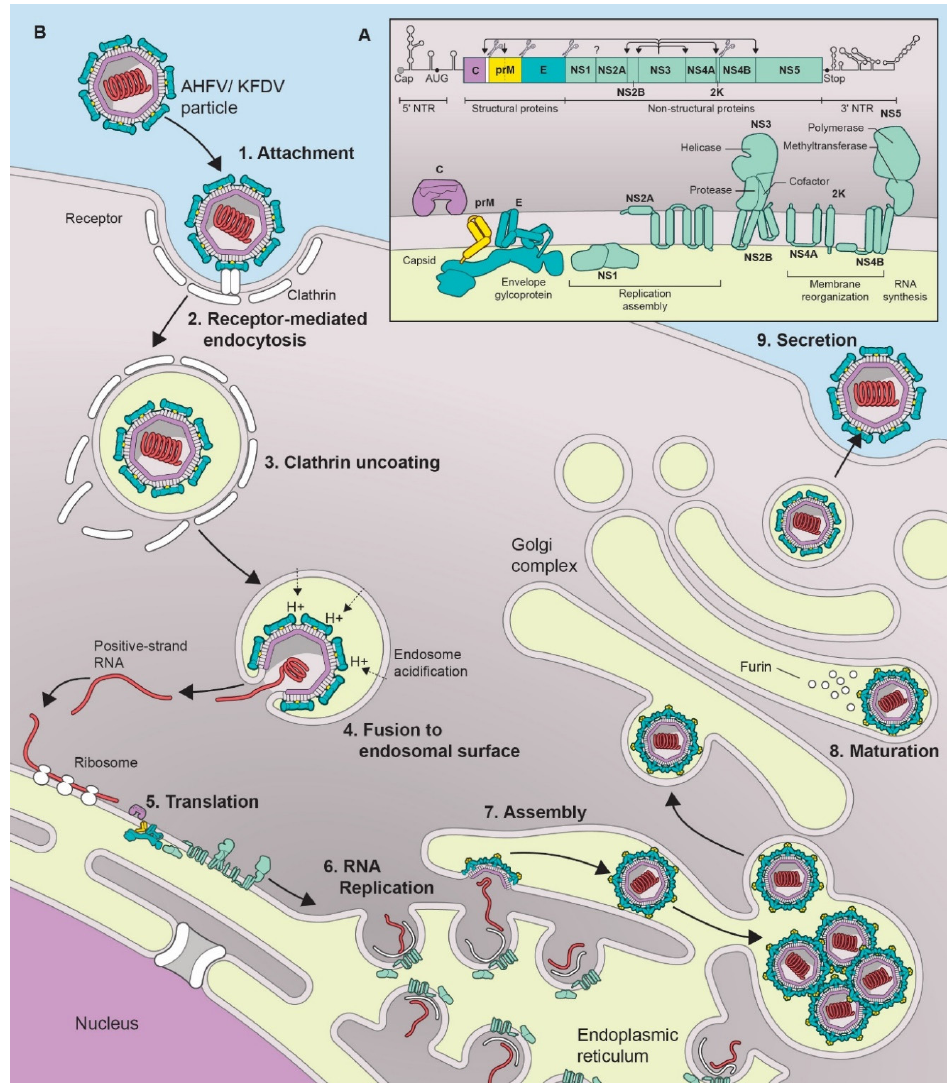
Figure 1. Flavivirus replication cycle and genome structure. ( A ) Schematic of a flavivirus genome, polyprotein , and the mature viral proteins. ( B ) Lifecycle of a typical flavivirus.